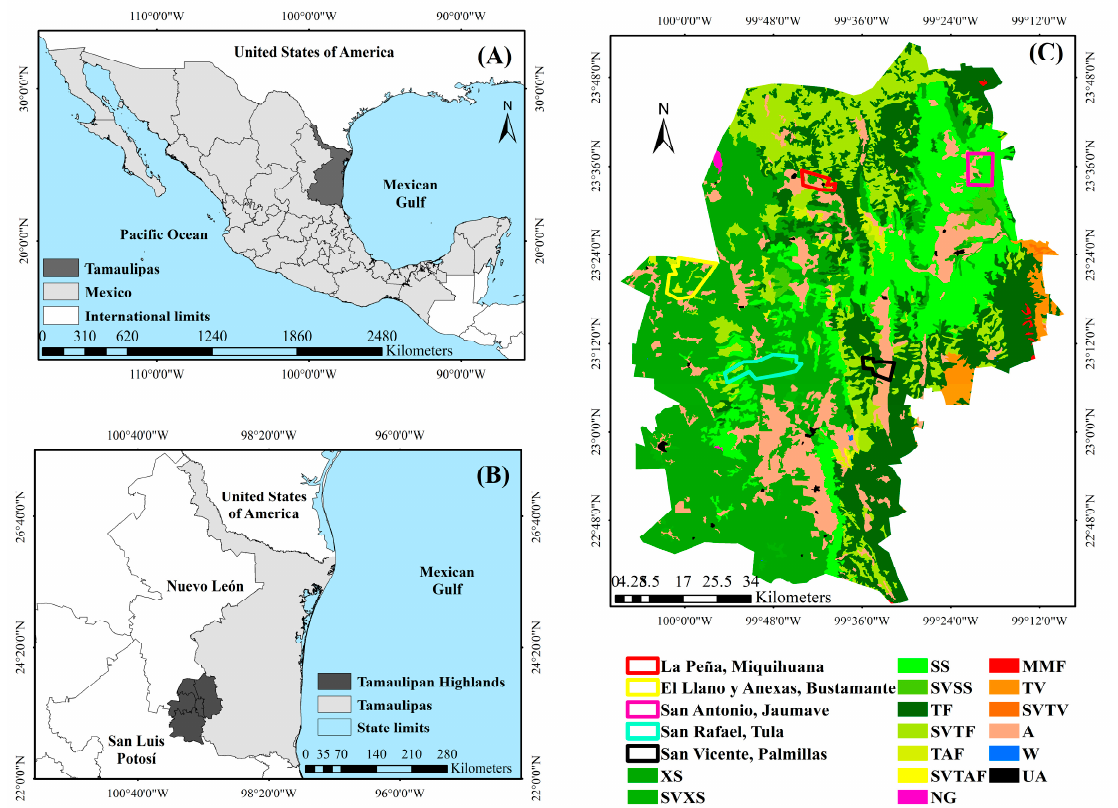
Figure 1. Location of the Tamaulipan Highlands (TH) in Tamaulipas, Mexico. ( A ) Location of Tamaulipas in Northeastern Mexico. ( B ) The geographical position of the TH in the state of Tamauli- pas. ( C ) Study communities (Ejidos) in the TH and soil and vegetation cover: XS—xerophilous scrub; SVXS—secondary vegetation of xerophytic scrub; SS—submontane scrub; SVSS—secondary vegetation of submontane scrub; TF—temperate forest; SVTF—secondary vegetation of temperate forest; TAF—tascate forest; SVTAF—secondary vegetation of tascate forest; NG—natural grassland; MMF—mountain mesophyll forest; TV—tropical vegetation; SVTV—secondary vegetation of tropical vegetation; A—agriculture; W—water; and UA—urban